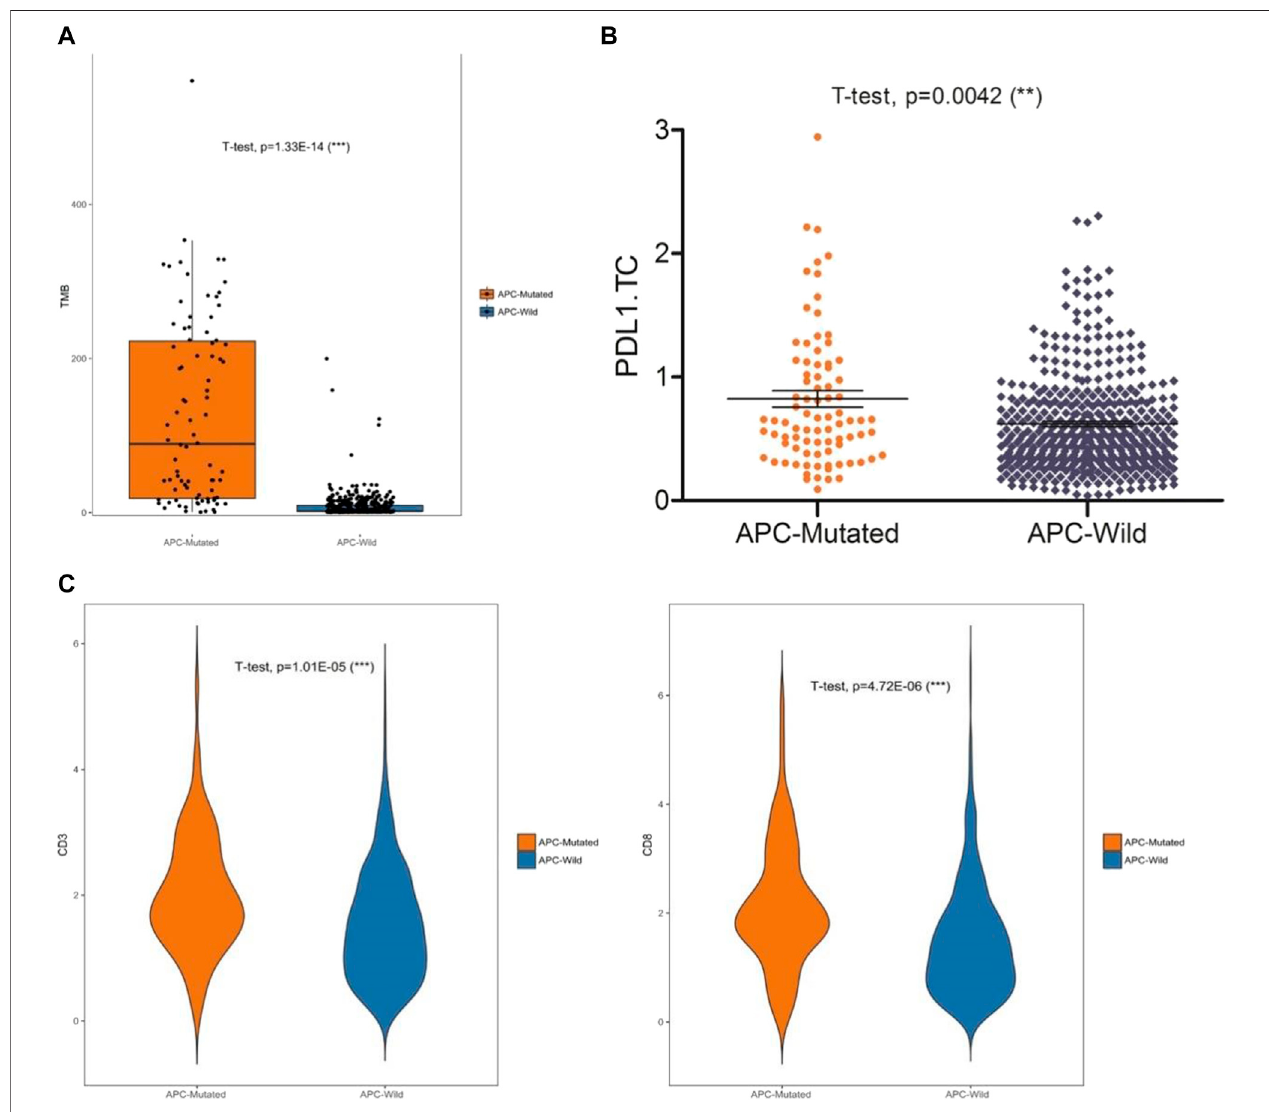
FIGURE 4 | Analysis of data in the TCGA database. (A) Relationship between APC and TMB (B) Relationship between APC and PD-L1 expression. (C) Relationship between APC and CD3 + and CD8 + T cell in fi ltrations.